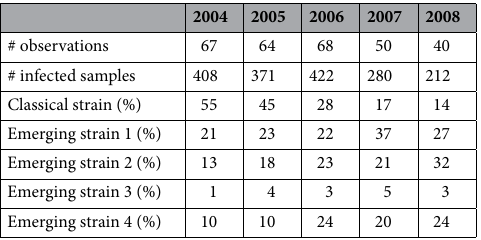
Table 1. Number of observations and corresponding proportions of classical and emerging strains.